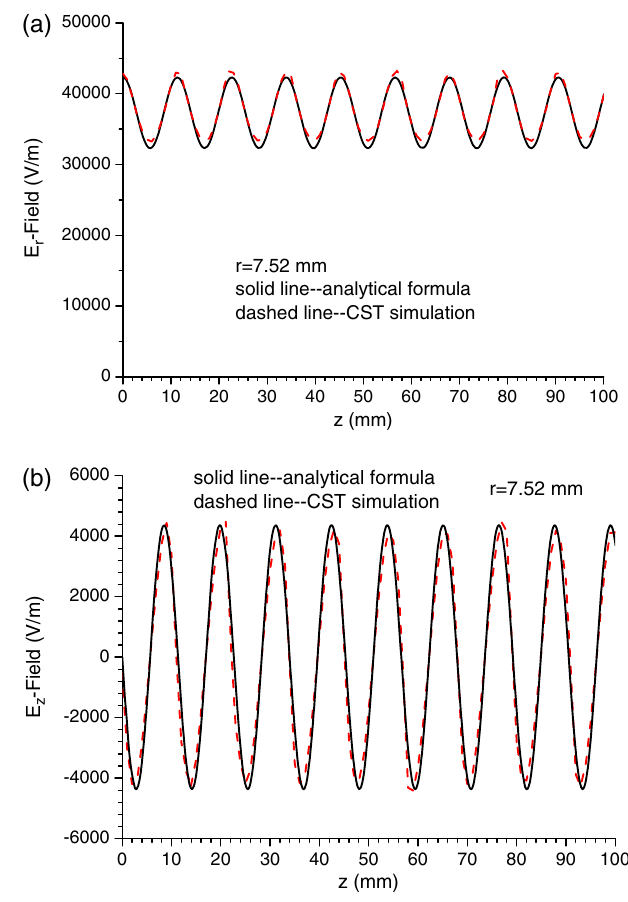
FIG. 4. Electric field components in the r direction (a) and the z direction (b) versus the longitudinal position z at a location of r ¼ 7 : 52 mm , where the other parameters are the same as in Fig.